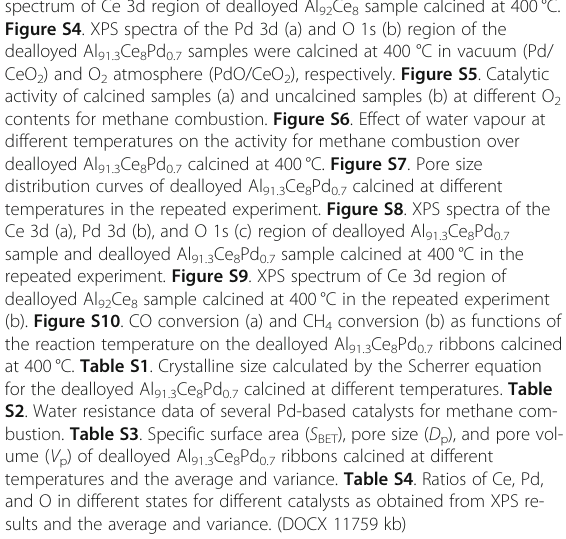
bustion. Table S3 . Specific surface area ( S BET ), pore size ( D p ), and pore vol- ume ( V p ) of dealloyed Al 91.3 Ce 8 Pd 0.7 ribbons calcined at different temperatures and the average and variance. Table S4 . Ratios of Ce, Pd, and O in different states for different catalysts as obtained from XPS re- sults and the average and variance. (DOCX 11759 kb)